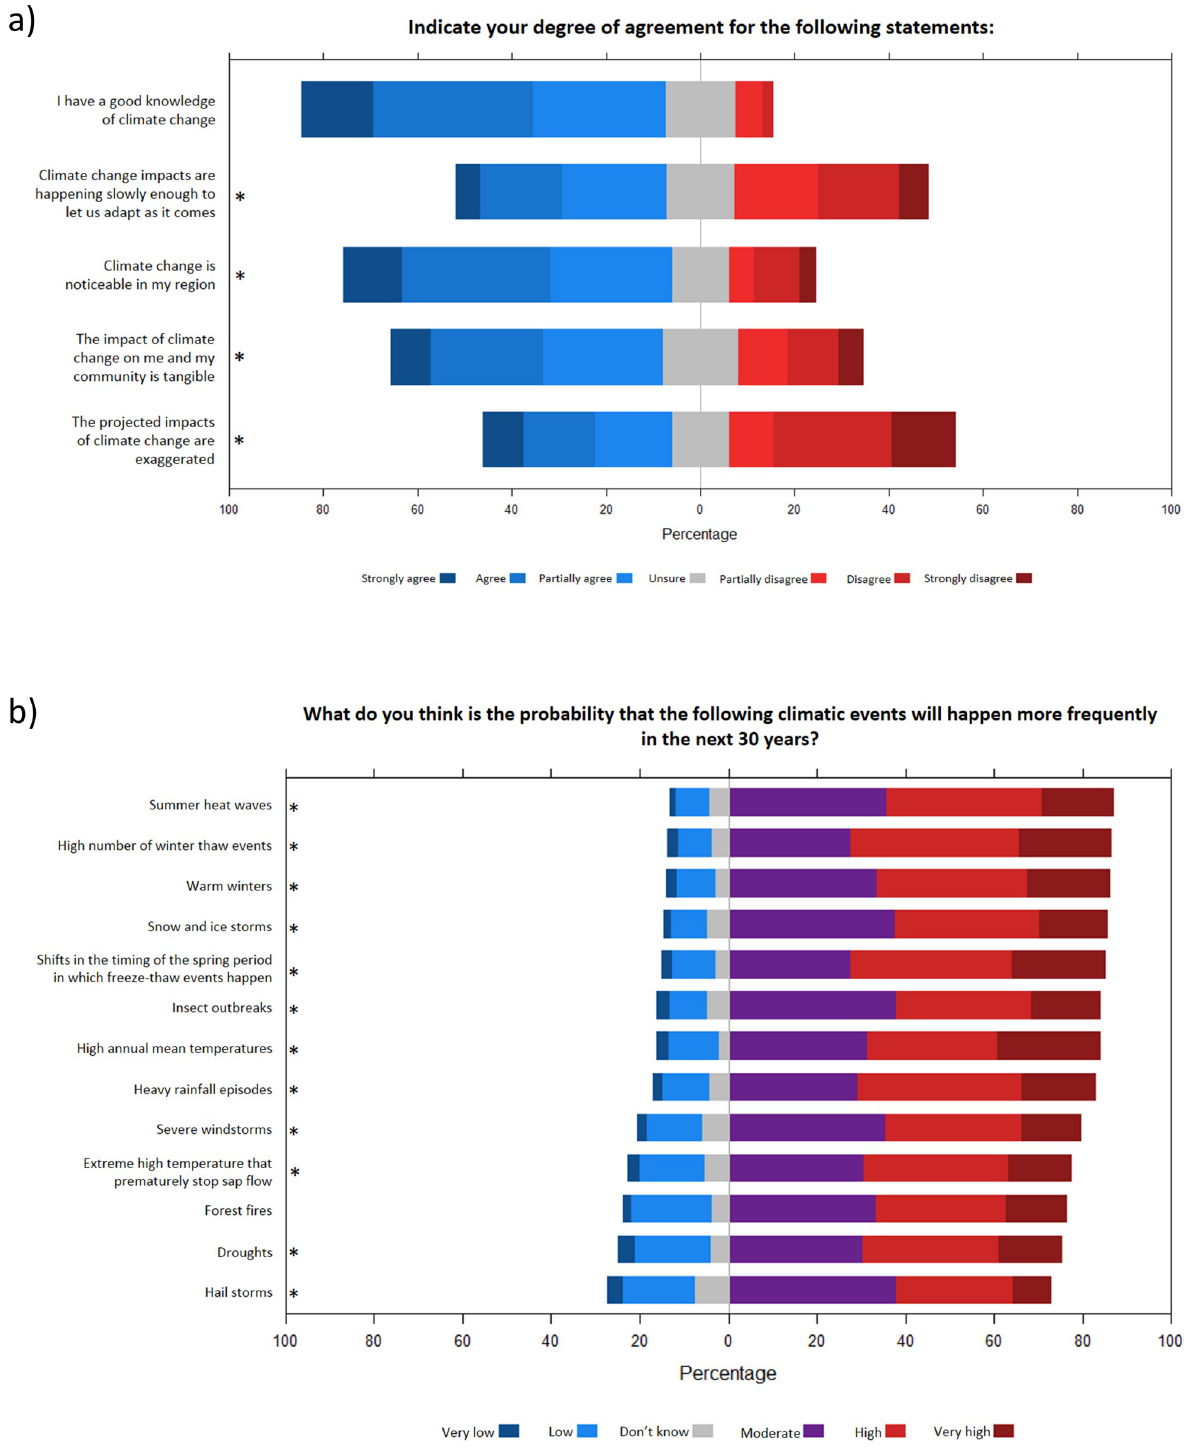
Fig 4. General impacts of climate change. a) Responses of the survey participants for general statements about climate change. b) Responses of the survey participants for the question What do you think is the probability that the following climatic events will happen more frequently in the next 30 years ? Statements followed by a � symbol indicate a significant effect of at least one predictor (see Table 3 and S3